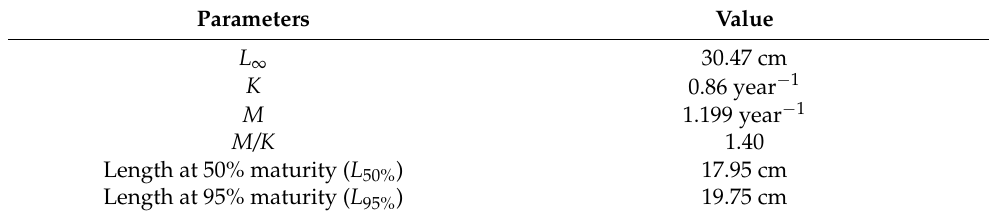
Table 4. Input parameters for LB-SPR analysis.